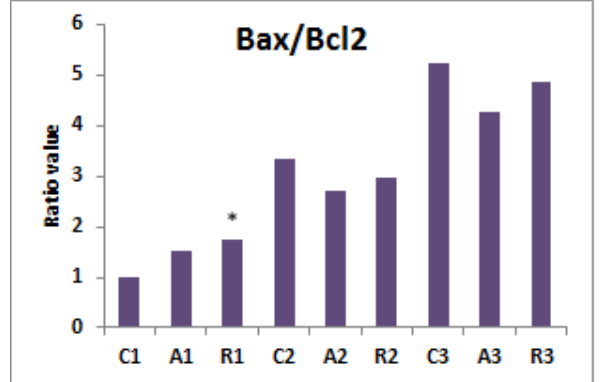
Figure 2. Bax/Bcl2 ratio value for each experimental group. *, p <0.05.